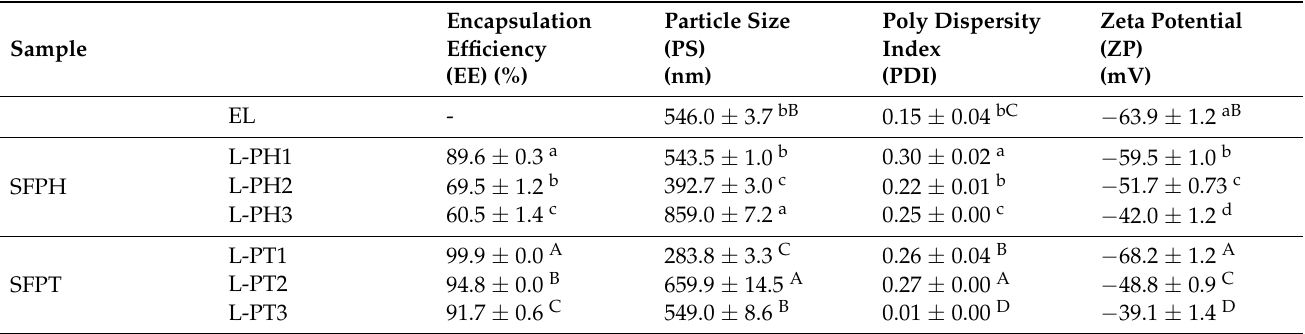
Table 1. Encapsulation efficiency (EE), particle size (PS), polydispersity index (PDI) and zeta potential (ZP) of liposomes loaded with SFPH and